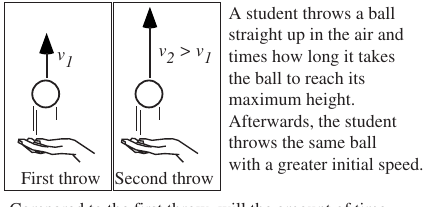
FIG. 4. Vertical toss question: speed cuing.